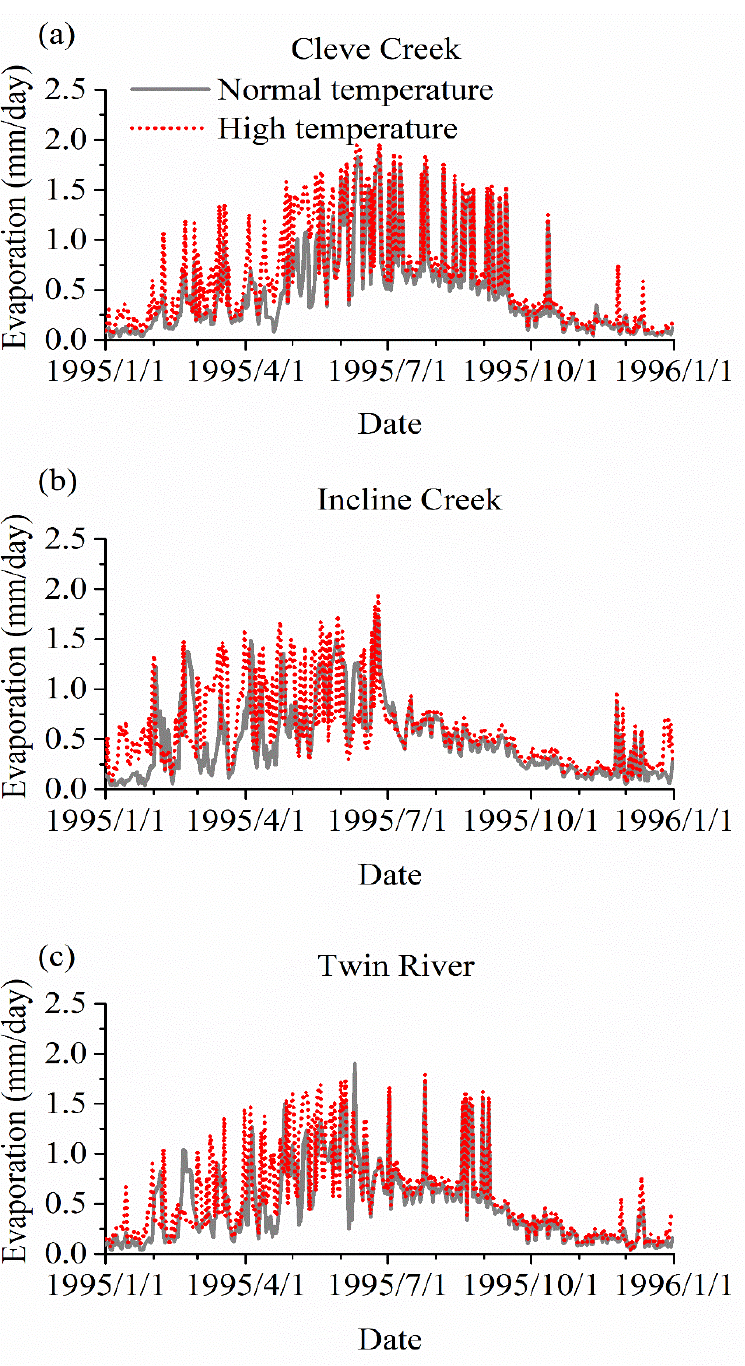
Figure 9. Comparison of evaporation under two different temperature scenarios in ( a ) Cleve Creek, ( b ) Incline Creek, and ( c ) Twin River watersheds without vegetation in 1995.